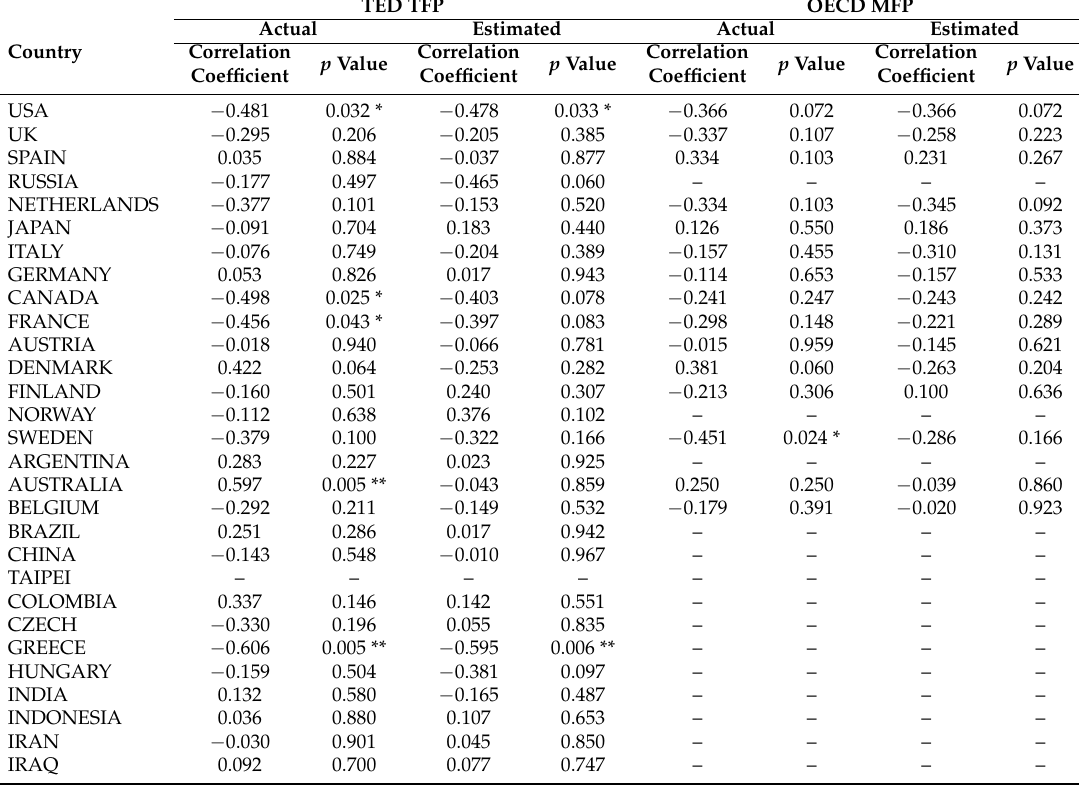
Table 5. The correlation between 1-year lagged change in total factor productivity (measured as logarithmic differences) and f e ,GDP on all energy except oil for both the TED TFP and OECD MFP calculations. The negative correlation is statistically signficant for a few countries but not the world overall. Results using Estimated f e ,GDP should be viewed as more representative because some Actual data f e ,GDP have missing data.* = p value < 0.05; ** = p value < 0.01. The countries with TFP in the Total Economy Database TM account for 89% − 92% of the world GDP from 1990 to 2010. The countries with MFP in the OECD account for 61% − 75% of the world GDP from 1985 to 2010 (66% in 1985 rising to 75% in 1995 then declining to 66% in 2009 and 61% in